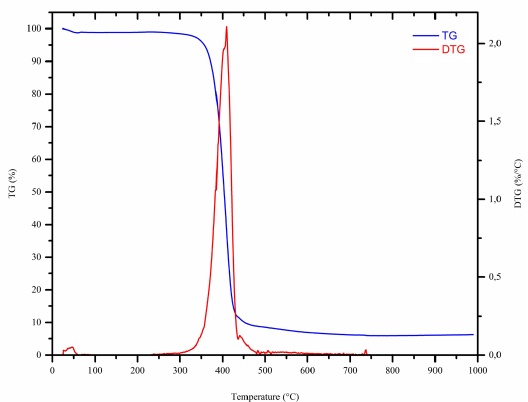
Figure 5. TG/DTG analysis of fiber after electrospinning deposition on Group 2 – Nanotubes of TiO